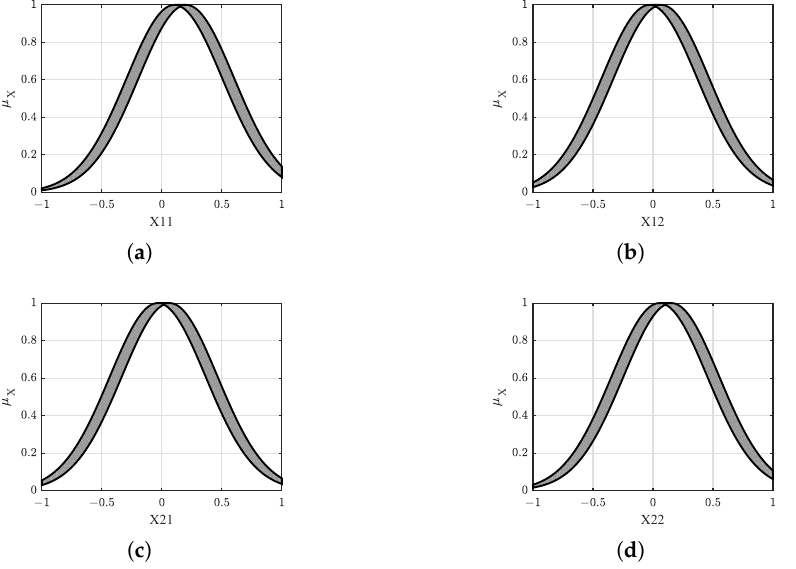
Figure 10. Distribution of the fuzzy set of antecedent for the DHSOIT2FS algorithm with normaliza- tion. ( a ) Fuzzy set of SOFS1’s first dimension. ( b ) Fuzzy set of SOFS1’s second dimension. ( c ) Fuzzy set of SOFS2’s first dimension. ( d ) Fuzzy set of SOFS2’s second